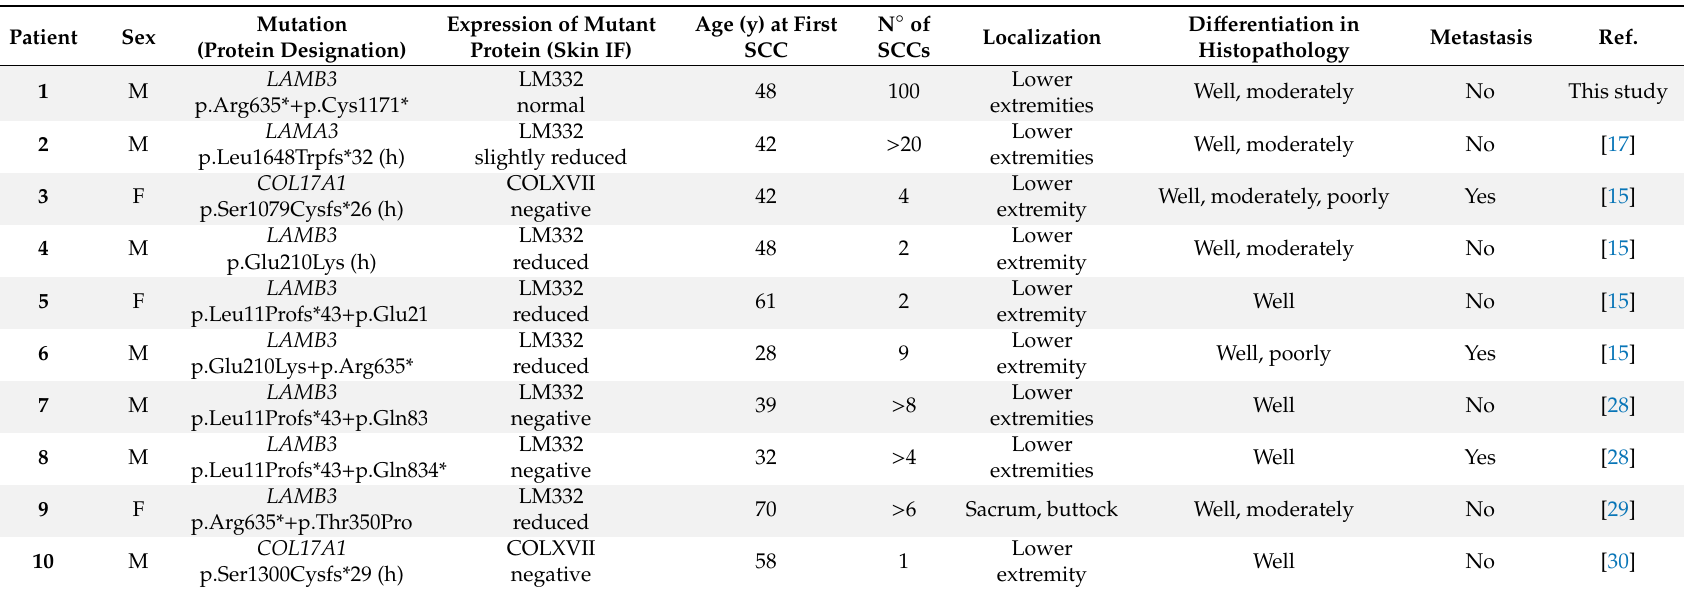
Table 1. Reported cases of squamous cell carcinoma in molecularly characterized JEB-GI